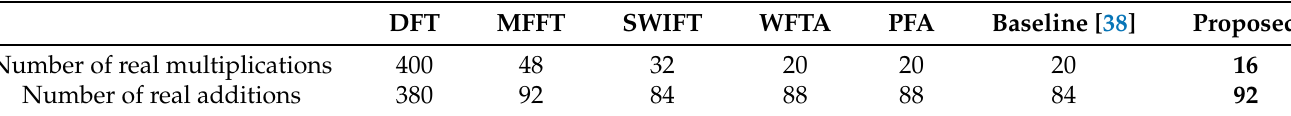
3. Computing L × 10-Point